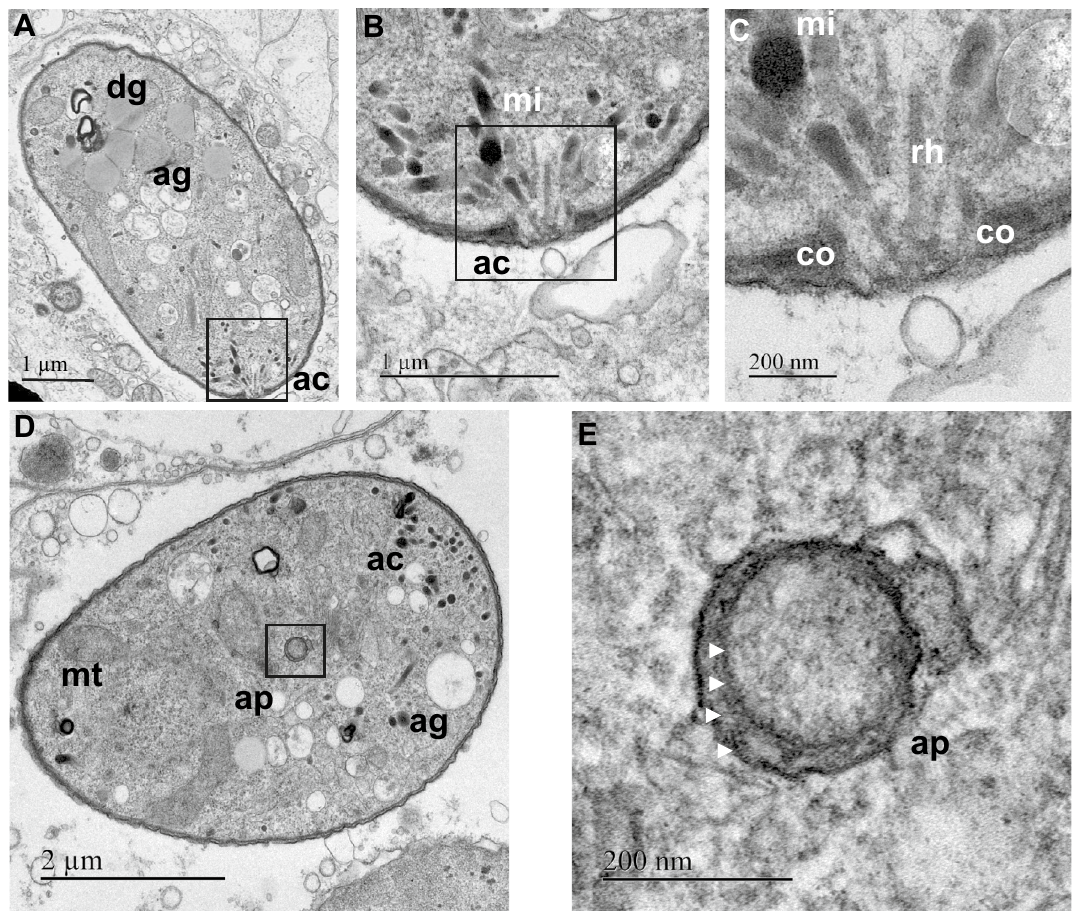
Figure 8. Ultrastructure of the BSM apical complex ( A to C ) and apicoplast ( D and E ). ( A ): general view of an early trophozoite with a visible apical complex (ac). ( B ) and ( C ) represent enlargement of the boxed areas in ( A ) and ( B ), respectively. Note the presence of micronemes (mi), rhoptries and conoids (co). ( D ): general view of an early trophozoite presenting an apicoplast (ap). ( E ): Larger magnification of the apicoplast surrounded by